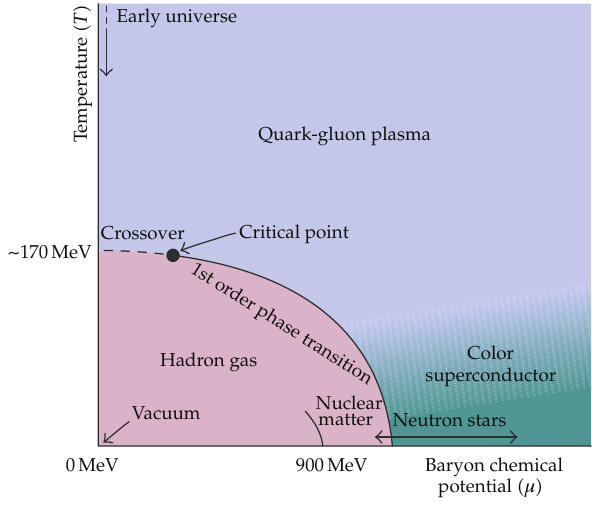
Figure 4: QCD phase